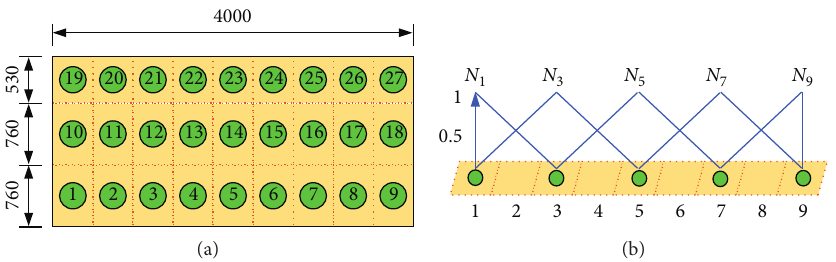
Figure 23: Element division and damage function: (a) element division of the updating model; (b) damage function of a girder. Table 8: Comparison of the identified and tested modal parameters for Cases 3, 4, and 5. Case 3 Case 4 Case 5 Exp. Freq. Mode (Hz)